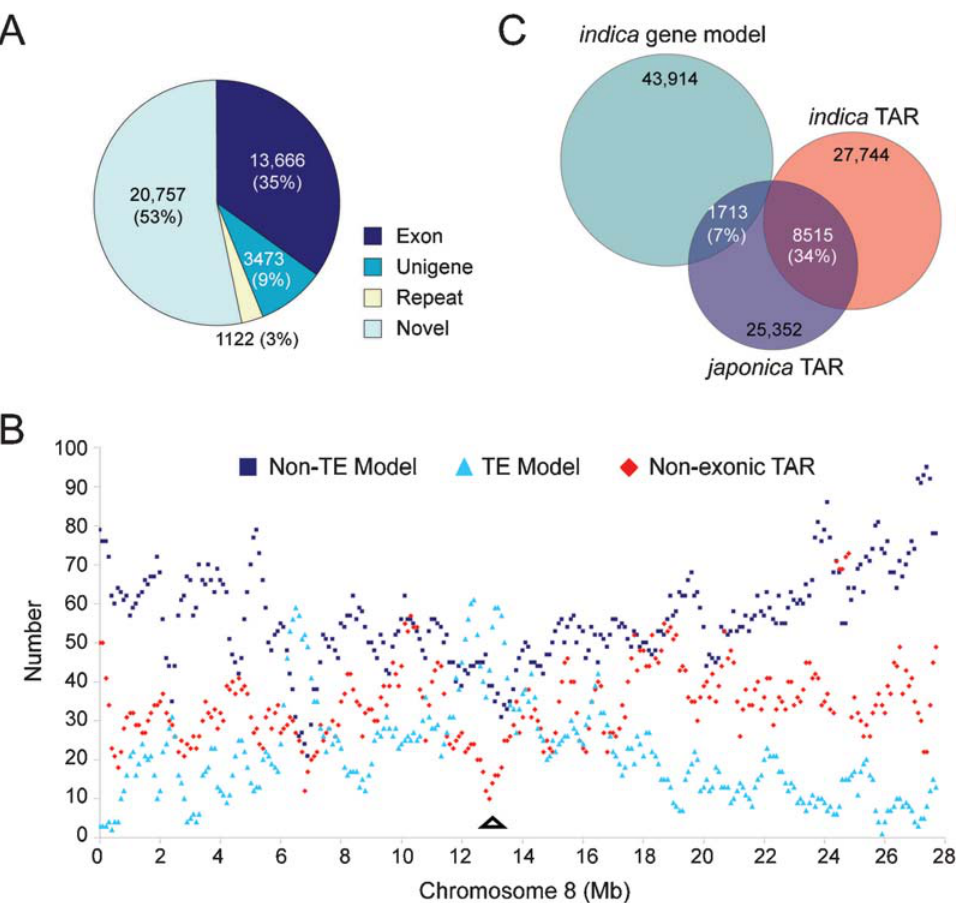
Figure 1. Characterization of japonica TARs. (A) Classification of all identified TARs based on known transcriptional evidence and sequences of known origin. Exon, exons of annotated gene models; Unigene, rice Unigenes in GenBank; Repeat, plant repetitive sequences and organelle insertions. (B) Density of different sets of transcription units along Chromosome 8. The number of transcription units was calculated in 500 Kb-sliding-windows with a 100 Kb step. Position of the centromere is indicated by the triangle. (C) Venn diagram showing the comparison of japonica non-exonic TARs with indica transcription units. Two independent comparisons were made. First, the japonica non-exonic TARs were compared with annotated indica gene models. Second, the japonica non-exonic TARs were compared with indica non-exonic TARs, which were identified outside of gene models from tiling array analysis of the indica genome. Shaded areas indicate japonica TARs that overlap with indica gene models or non-exonic TARs.